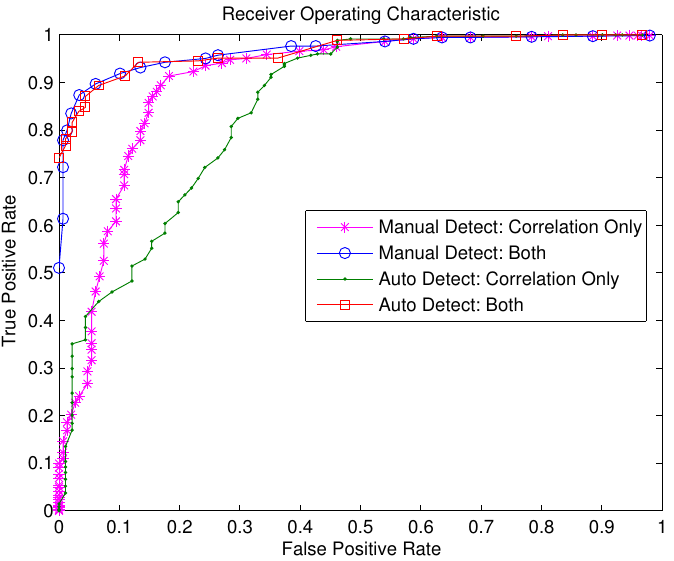
Figure 15. Comparison of receiver operating characteristic curves when using both metrics versus only